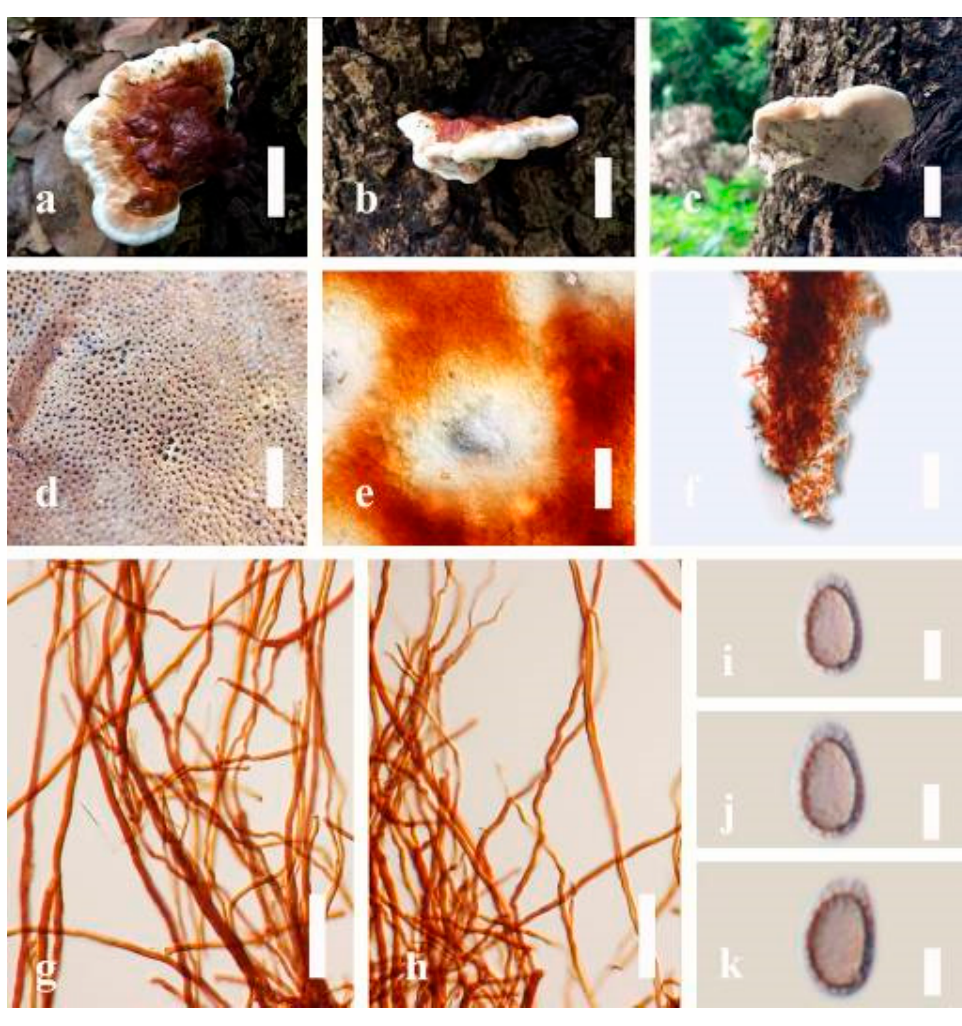
Figure 12. Morphology of Ganoderma resinaceum (MFLU 19-2153): ( a – c ) mature basidiomes; ( d ) pore characteristics; ( e ) hyphae of pore in KOH; ( f ) hyphae of tube layers in KOH; ( g , h ) context hyphae in KOH; ( i ) basidiospores in Melzer’s reagent; ( j , k ) basidiospores in KOH. Scale bars: ( a – c ) = 4 cm, ( d ) = 1000 μ m, ( e ) = 150 μ m, ( f ) = 30 μ m, ( g , h ) = 50 μ m, ( i – k ) = 5 μ m. Ganoderma sanduense Hapuar., T.C. Wen and K.D. Hyde, Mycosphere 10, 274 (2019)